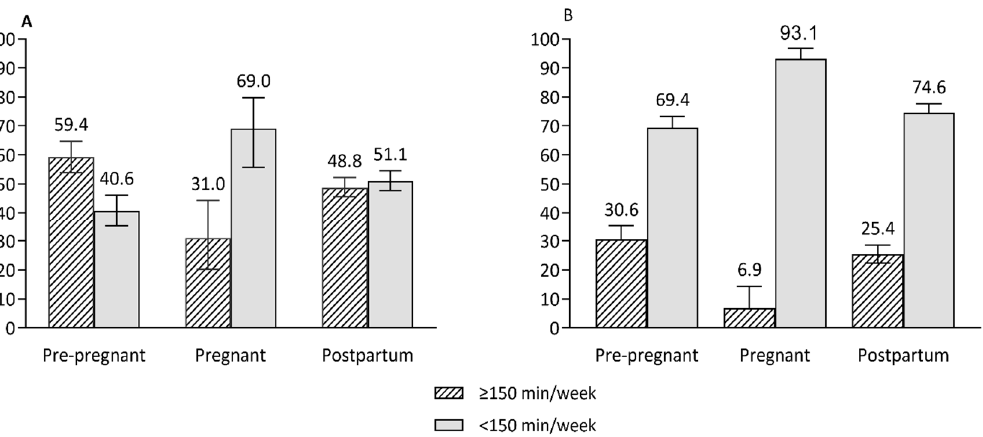
Figure 3. The proportions of women who spent time performing physical activity at least 150 min per week or more across reproductive life stages. ( A ) Total minutes of physical activity per week, ( B ) moderate–vigorous intensity activity per week. Error bars represent 95% CI of proportions.